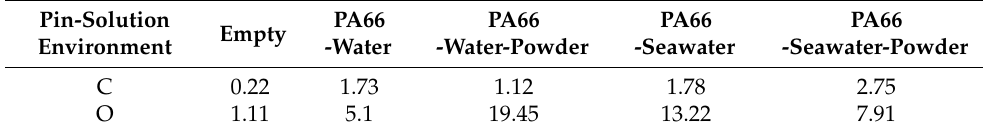
Figure 12. SEM image of wear marks on the 1a90 aluminum plate matched with PA66 pins in solution with powder. Table 7. Element analysis of wear marks on the aluminum plate against PA66